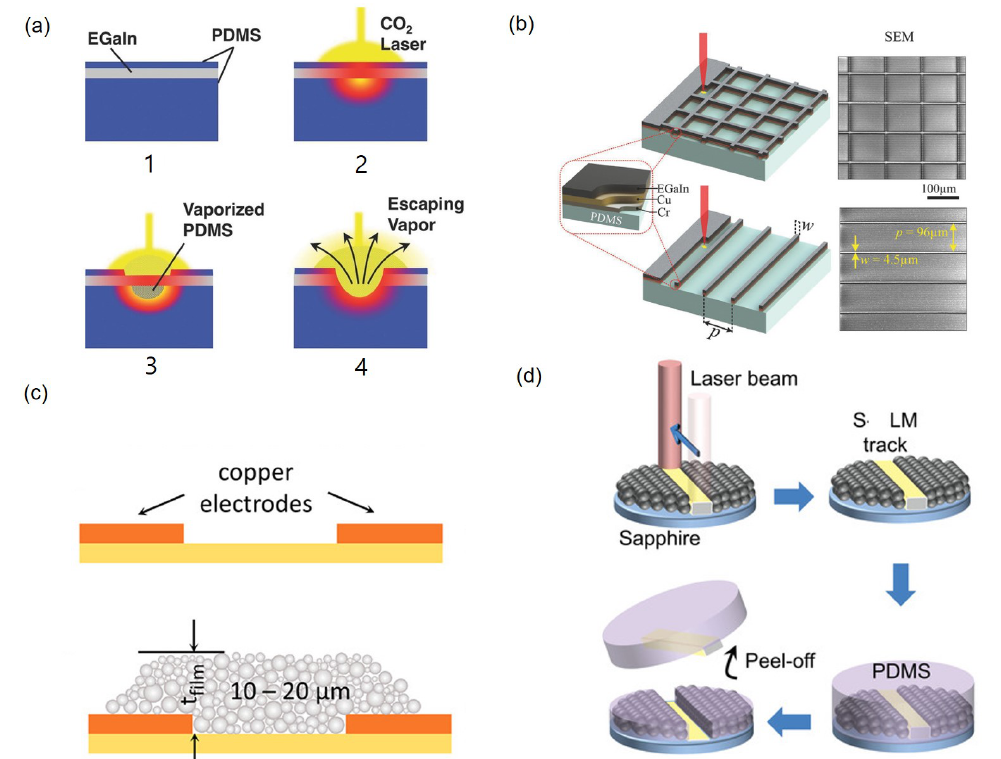
Figure 7. ( a ) Laser ablation creates liquid metal patterns using the liquid metal film between two PDMS layers by removing residual materials. (1) A liquid metal is coated with a thin layer of PDMS to prevent oxidation and limit exposure to debris. (2) Upon exposure to the laser, the sample is locally heated and (3) PDMS from top and bottom layers vaporize. (4) When the pressure difference between the vaporized polymer and atmosphere exceeds the surface tension of the liquid metal film, the vapor will puncture the liquid film and escape. Reproduced with permission from [62]; published by John Wiley and Sons, 2014. ( b ) The schematic and scanning electron microscope (SEM) images of the square grid and parallel line patterns of 4.5 µm wide EGaIn traces; they are patterned by microscale laser ablation of the thin-film architecture (Liquid metal/Copper/Chromium) on a PDMS substrate. Reproduced with permission from [63]; published by John Wiley and Sons, 2018. ( c ) Liquid metal nanoparticles are sintered by using laser on a surface with metal patterns. Reprinted with permission from